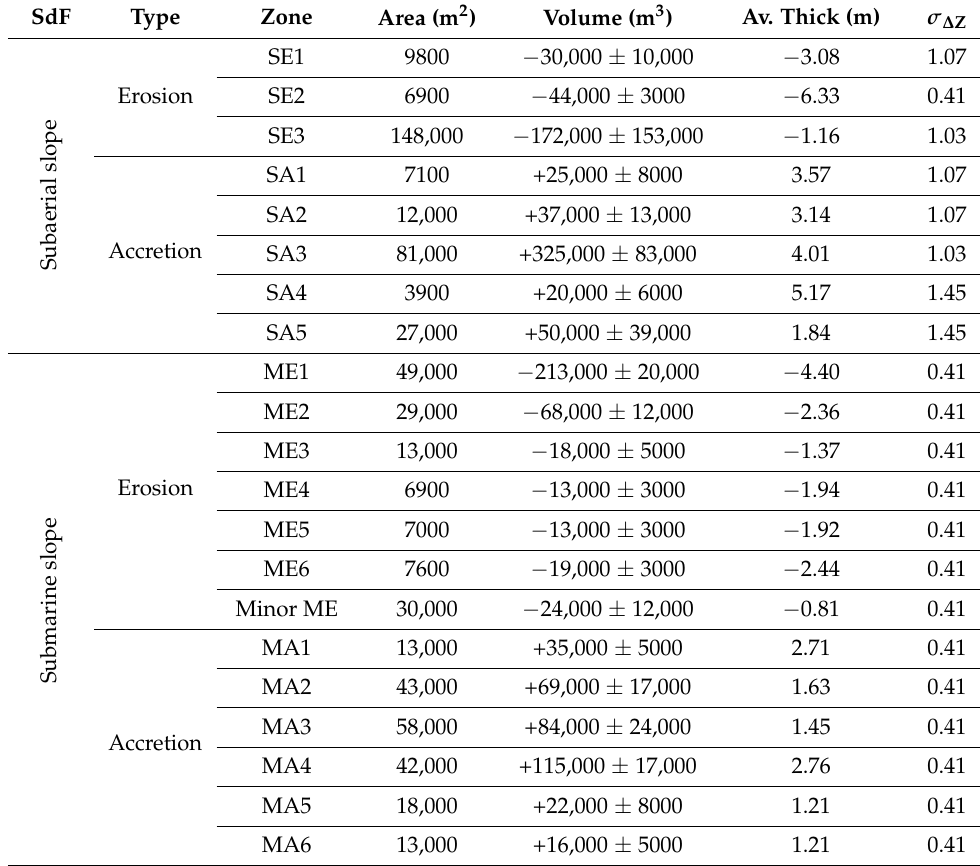
Table 6. Area, volume, average thickness, and associated σ ∆ Z for the main topo-bathymetric changes recorded on the Sciara del Fuoco slope during the overall monitoring period, including the subaerial and the submarine analysis (July 2021–February